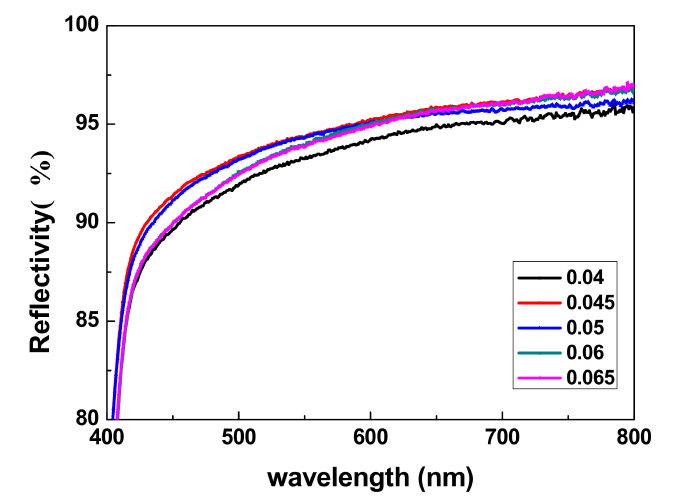
Figure 8. Light reflectivity of TiO 2 bifunctional sheet.